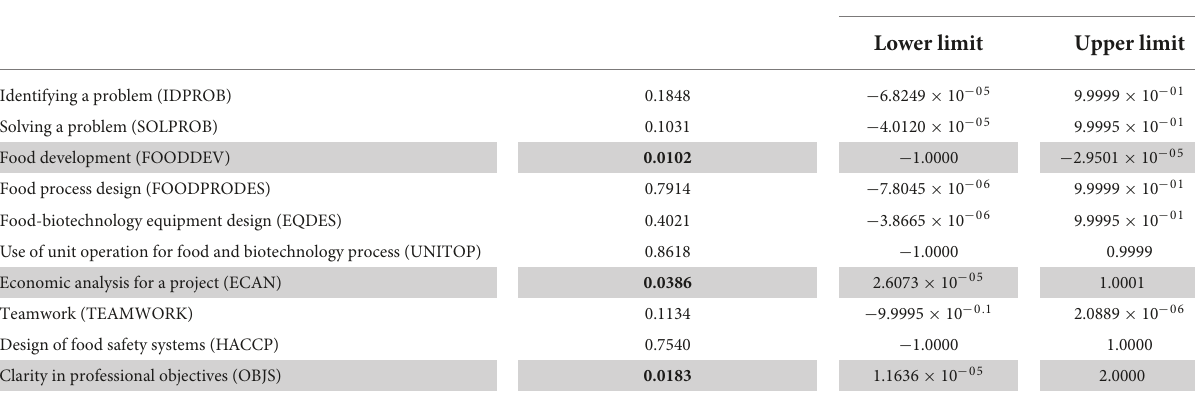
Confidence interval (95%) Mann-Whitney-Wilcoxon Test with two tails